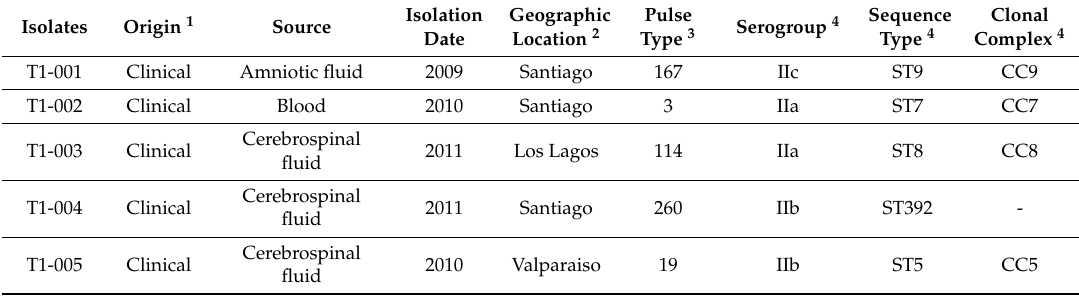
Table 1. Metadata and molecular characterization of L. monocytogenes isolates used in this